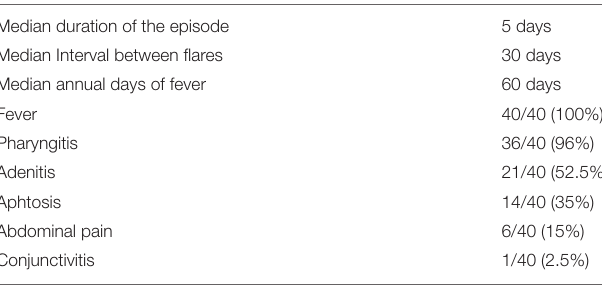
TABLE 1 | Clinical features of the 40